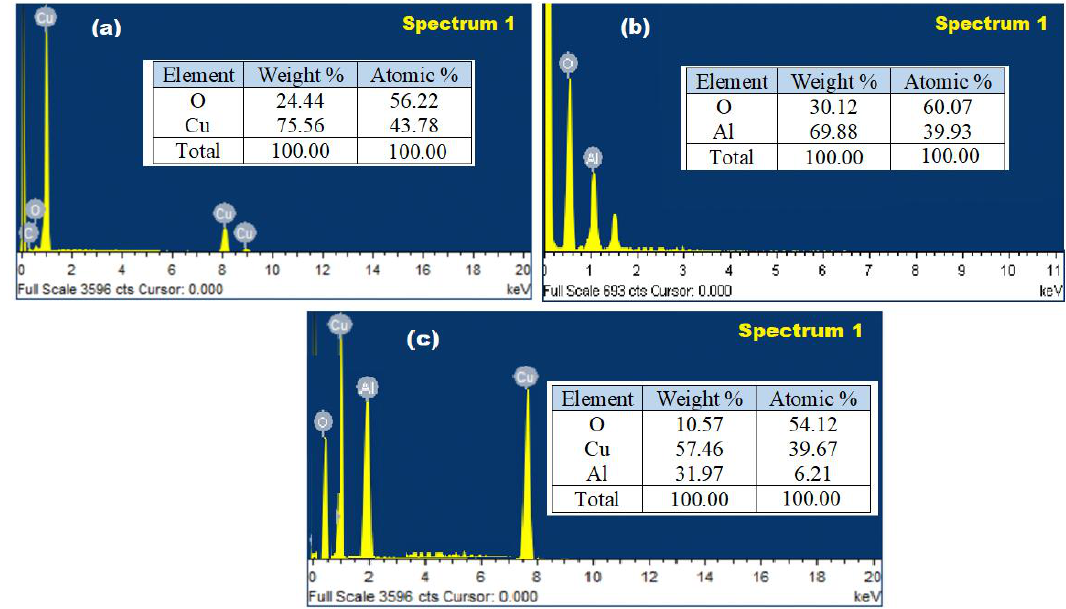
Figure 7. Energy Dispersive X-Ray (EDX) analysis of ( a ) CuONPs, ( b ) Al 2 O 3 NPs and ( c ) CuO/Al 2 O 3 nanocomposite.